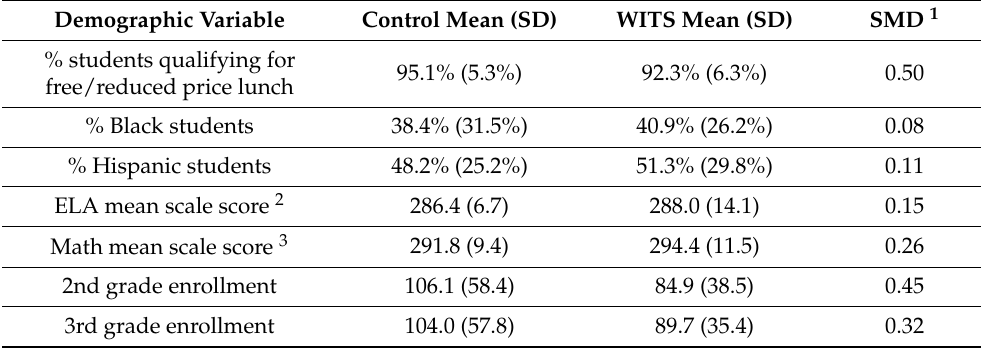
Table 1. School demographics of the Control and the Wellness in the Schools (WITS) Intervention schools. Demographic Variable Control Mean (SD) WITS Mean